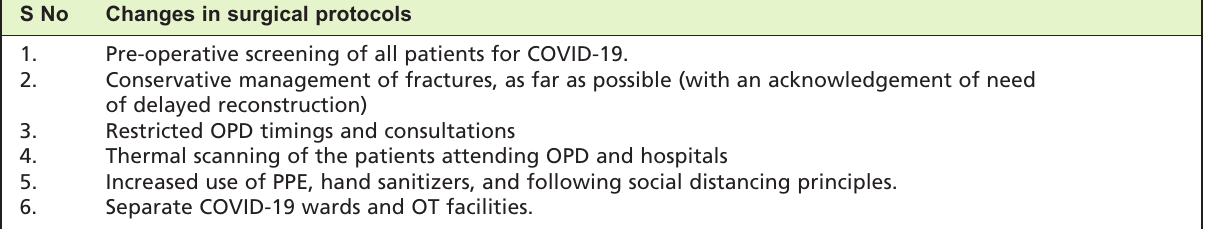
Changes instituted in the surgical protocols of Table III: